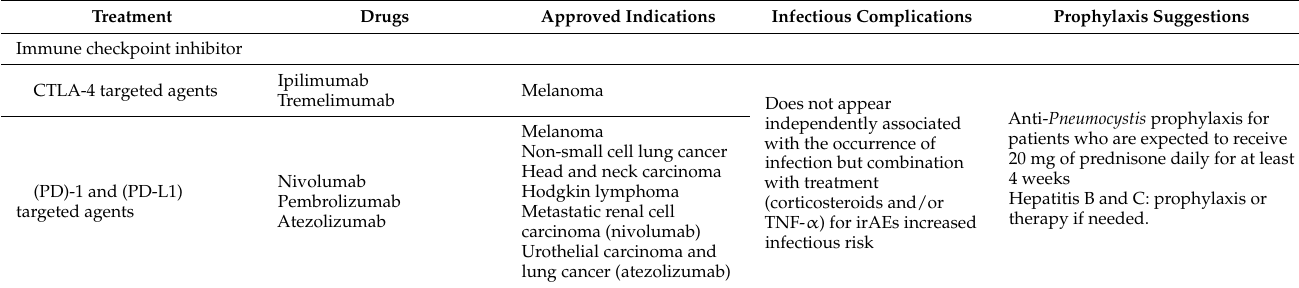
Table 2. Risk infections with new targeted therapies (Adapted from